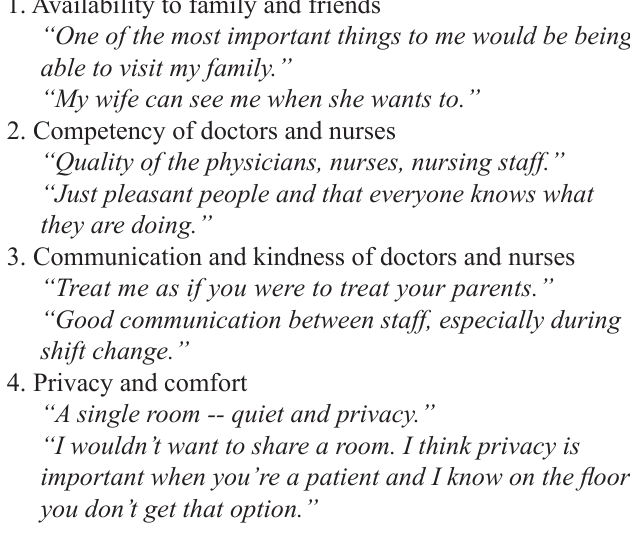
Figure. Hypothetical clinical scenario. CT , computed